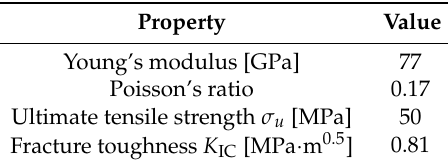
Table 4. Mechanical properties of quartz glass.